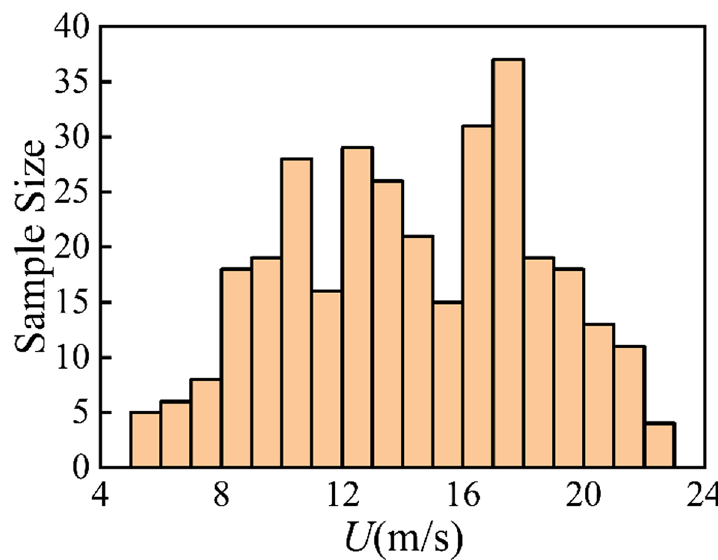
Fig. 13 Sample sizes in different wind velocity ranges (1 m/s)